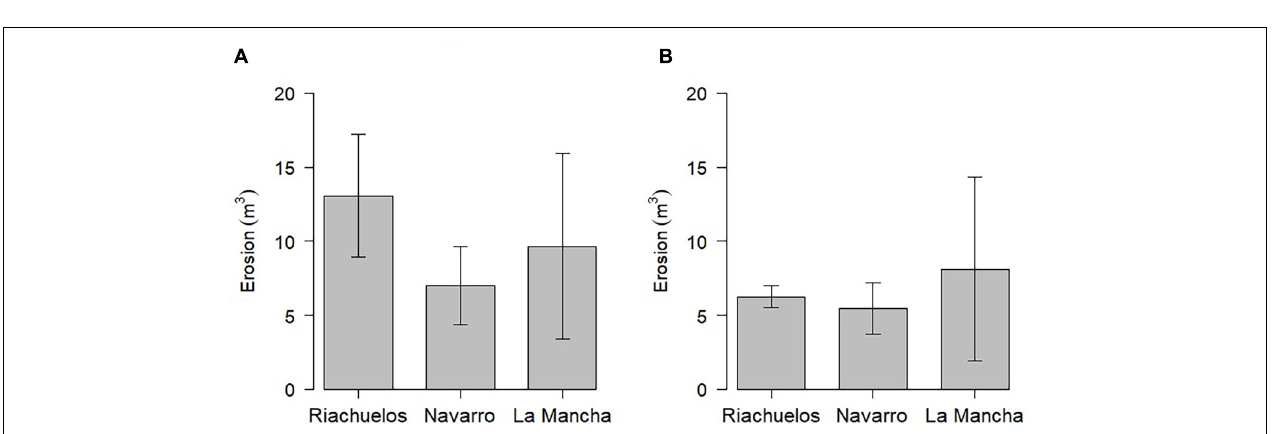
FIGURE 8 | Erosion at the study sites: (A) mean erosion on the three transects; (B) mean erosion on the frontal dunes (from the lee slope to the windward slope) and the lowest seaward point surveyed.